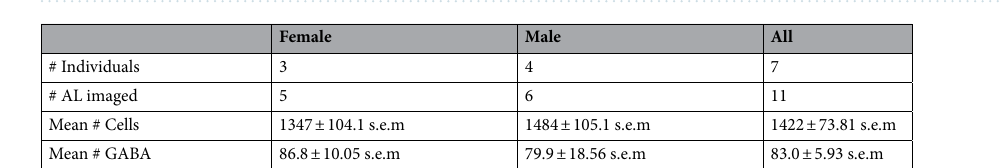
Figure 1. Frontal sections through the antennal lobe of Locusta migratoria . Sections were labeled using anti- acetylated α-tubulin ( a ) and anti-GABA ( b ) antisera, and the nuclear marker DAPI ( c ). To visualize primary neurites, sections were labeled against acetylated α-tubulin. GABA-IR local neurons (asterisk) were found in the frontal cell group of the antennal lobe. Somata of GABA-IR local neurons were typically larger compared to other cells ( c ). Most PN are also found in the frontal cell group, but had significantly smaller nuclei (arrowhead). In d , white color indicates colocalisation of GABA and acetylated α-tubulin. PN and GABAergic LN neurites (arrow) arborize into glomeruli. No arbors or connecting neurites were found on the dorsal side of the antennal lobe (segmented line). Scalebar = 100 µm.